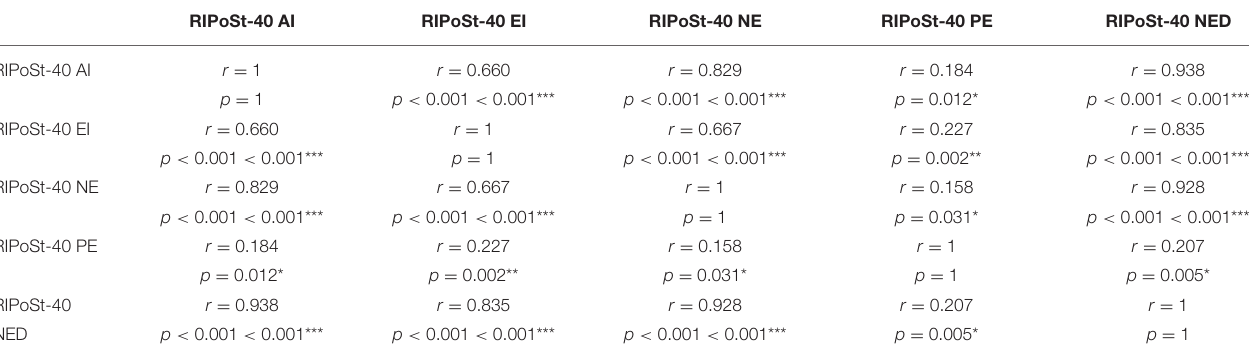
TABLE 3 | RIPoSt-40 subscale internal